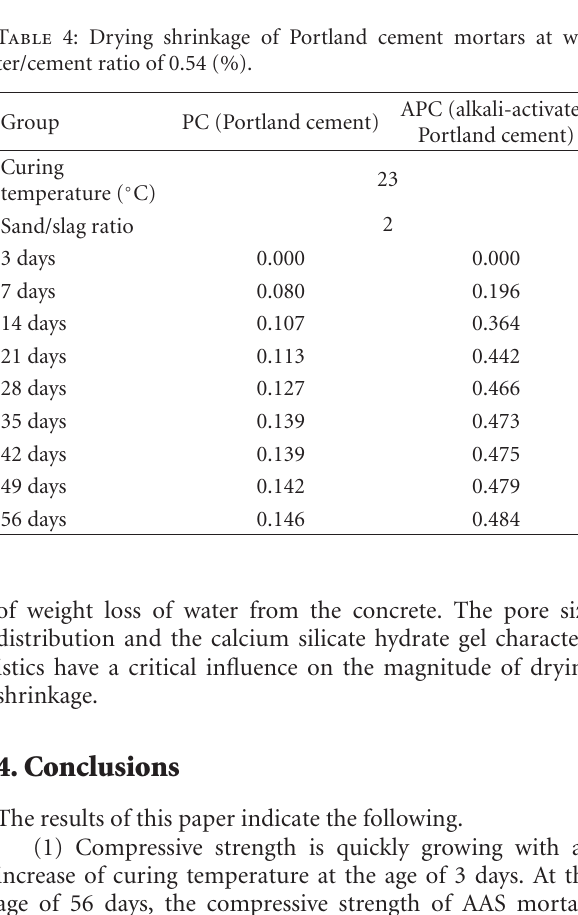
Figure 11: Drying shrinkage of AAS mortars ( L/S = 0 . 64).